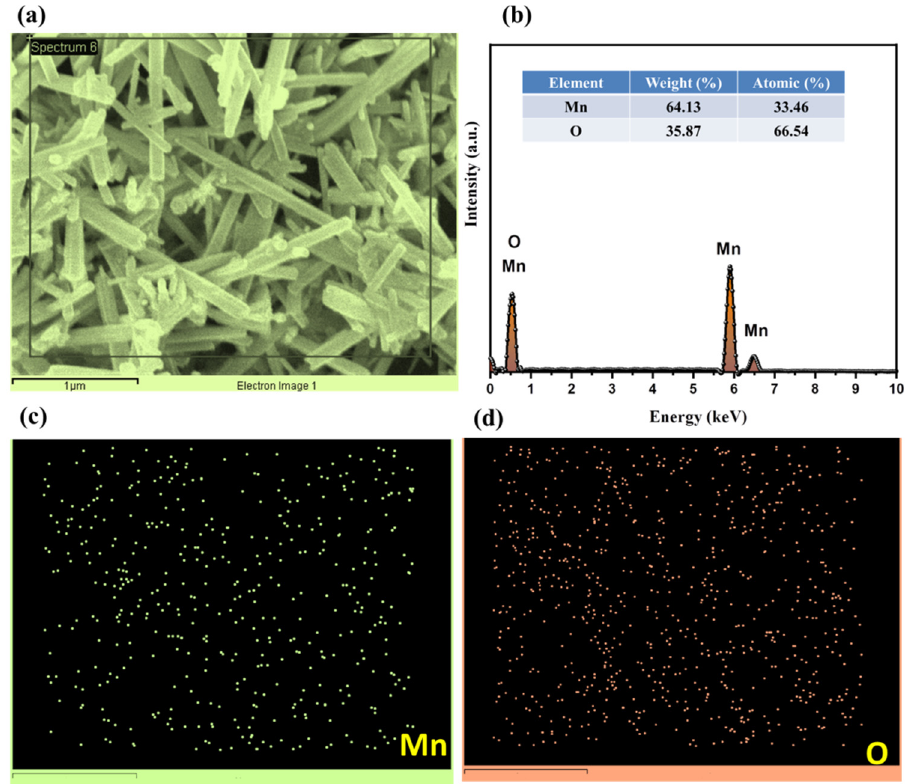
Figure 3. EDX electron image ( a ), EDX spectrum ( b ), and mapping images ( c , d ) of the prepared α -MnO 2 .